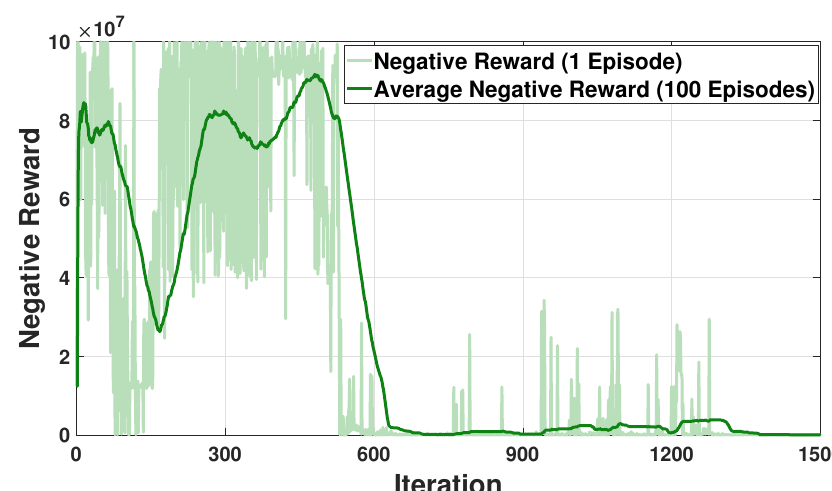
Figure 6. Negative reward convergence for the SESS agent.